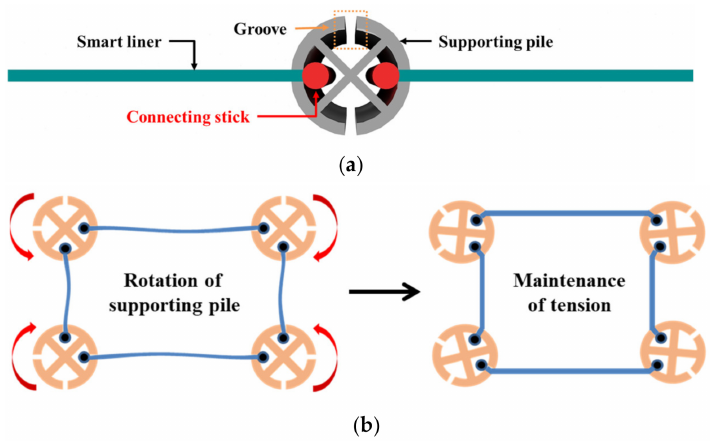
Figure 5. Detailed concept design of RSIM: ( a ) shape of the supporting pile and connection between the supporting pile and the smart liner and ( b ) maintenance method for the tension of the smart